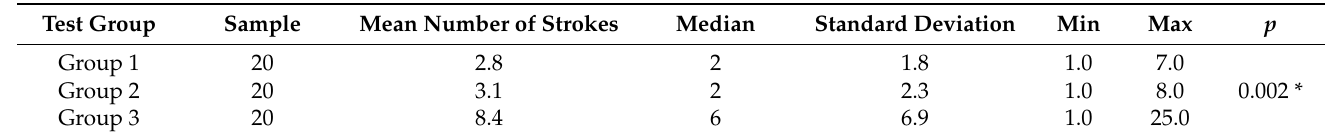
Table 2. The numbers of shear strokes applied to the